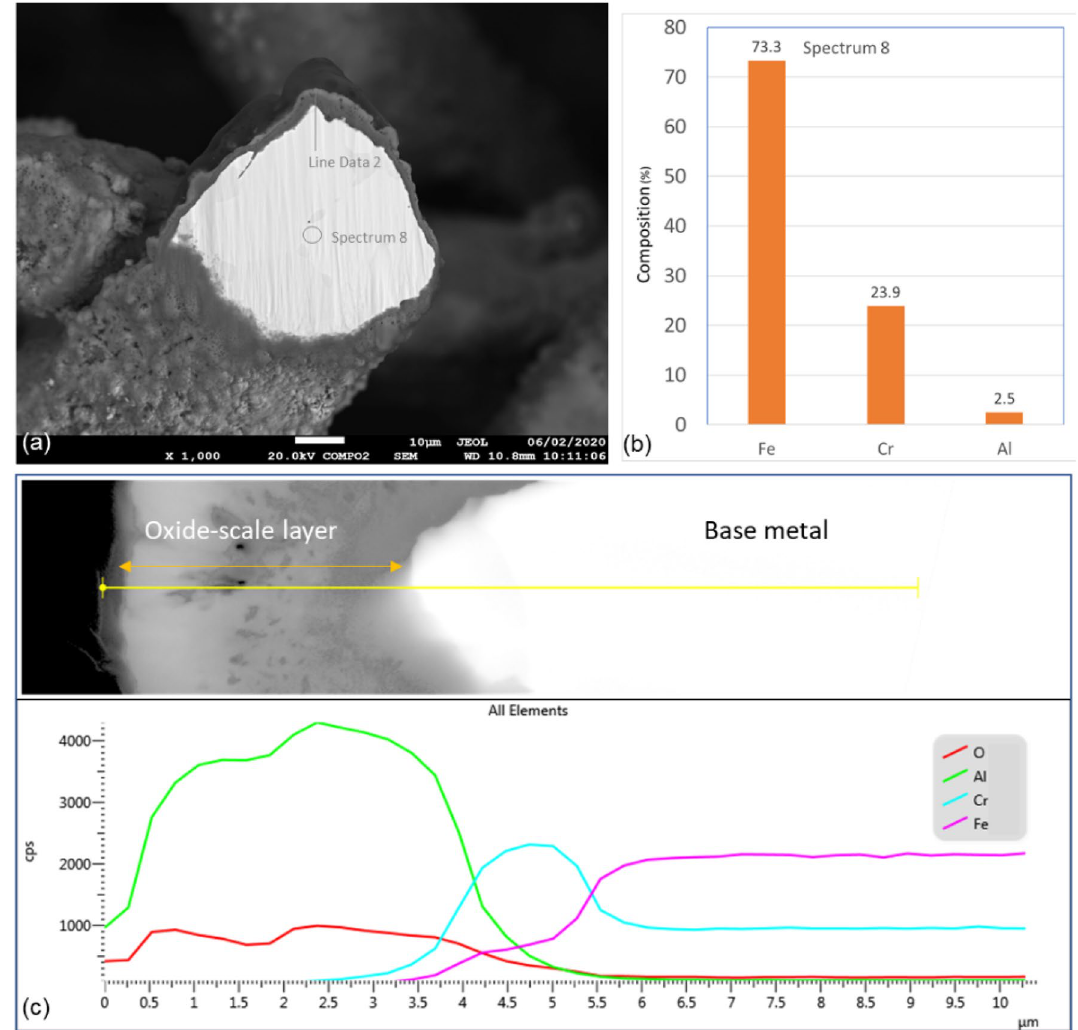
Figure 11. ( a ) Cross-section of Sample 3, 40 µm fiber; ( b ) EDS Scan of Spectrum 8; ( b ) The characteristic x-ray counts along the specified line scan (Line Data 2) marked in Fig.